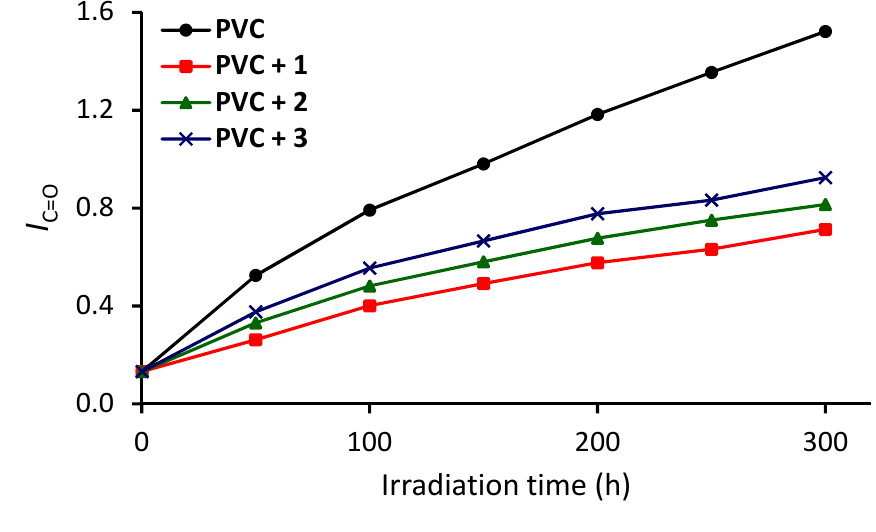
Figure 2. Changes in the I C=O index of PVC films.